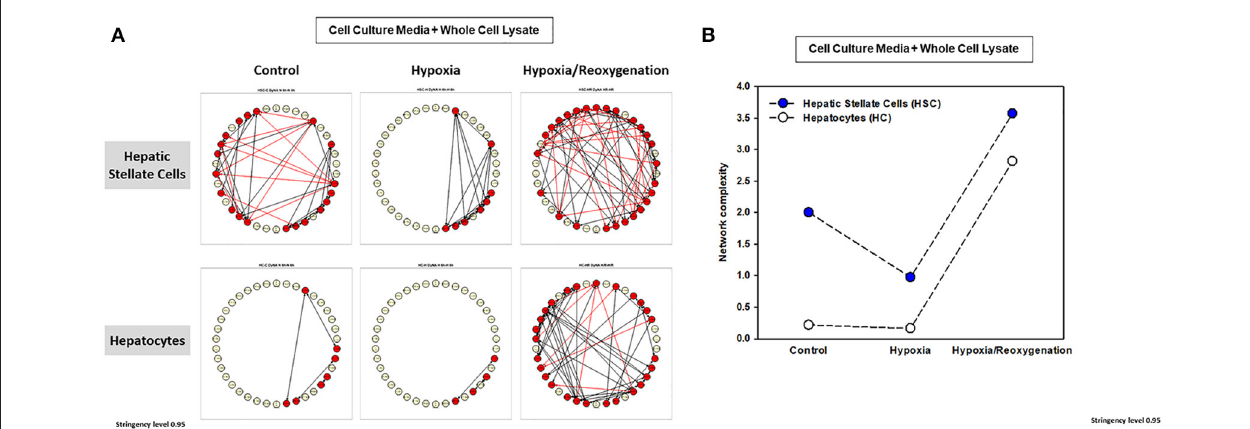
FIGURE 6 | Network Analysis of inflammatory mediators using the combined data of both the cell culture media (CCM) and whole cell lysate (WCL) in mouse hepatic stellate cells (HSC) and hepatocytes (HC). Freshly isolated HSC and HC from C57BL/6 mice were cultured under 21% O 2 for 6h (control), hypoxia (1% O 2 ) for 6h or hypoxia (6h) followed by reoxygenation for 18h. Inflammatory mediators released into cell culture media (CCM) and in whole cell lysate (WCL) were measured by Luminex TM and Network Analysis was performed as described in Materials and Methods . The figure shows the networks and the detailed connectivity (stringency level 0.95) for each experimental condition combining the data in CCM and WCL (A) . Black and red arrows represent positive and negative connections, respectively. (B) Compares the combined network complexity in HSC vs. HC.